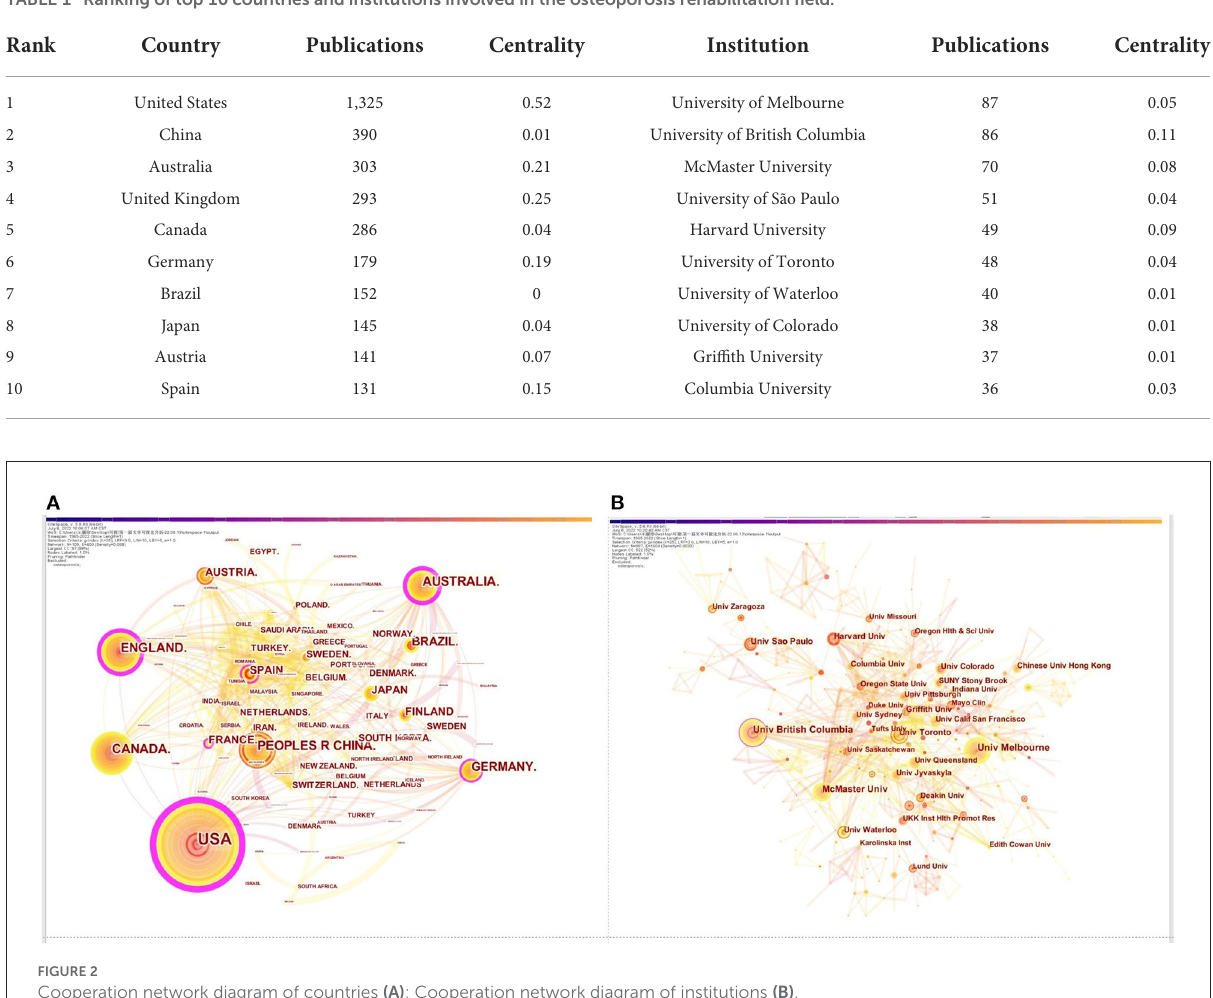
Data analysis tool and statistical